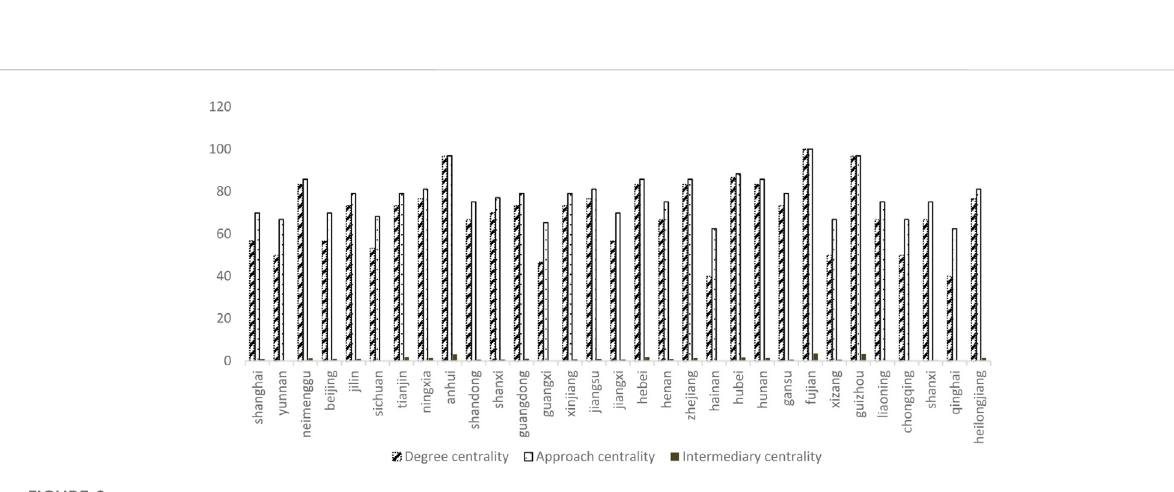
FIGURE 8 Module analysis of spatial assosiation network of green total factor productivity in service